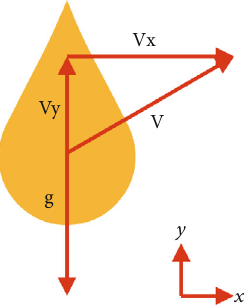
Figure 1: Free body diagram illustrating the initial condition of a droplet after